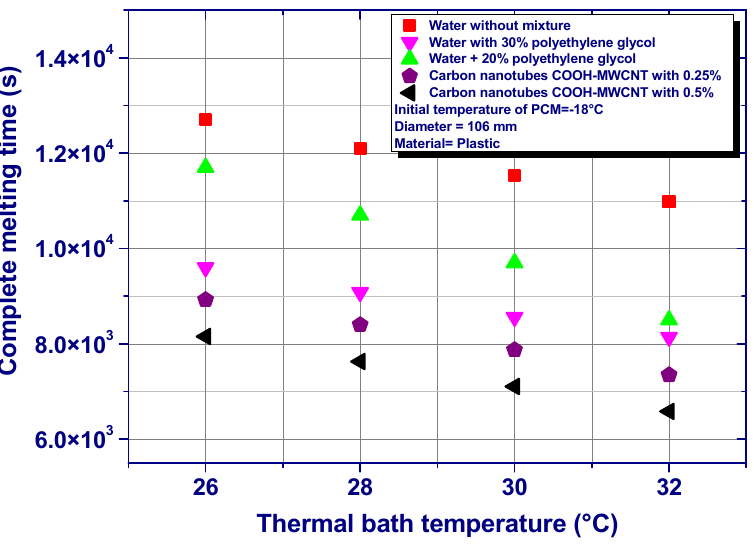
Figure 15. Impact of PCM on the complete melting time.